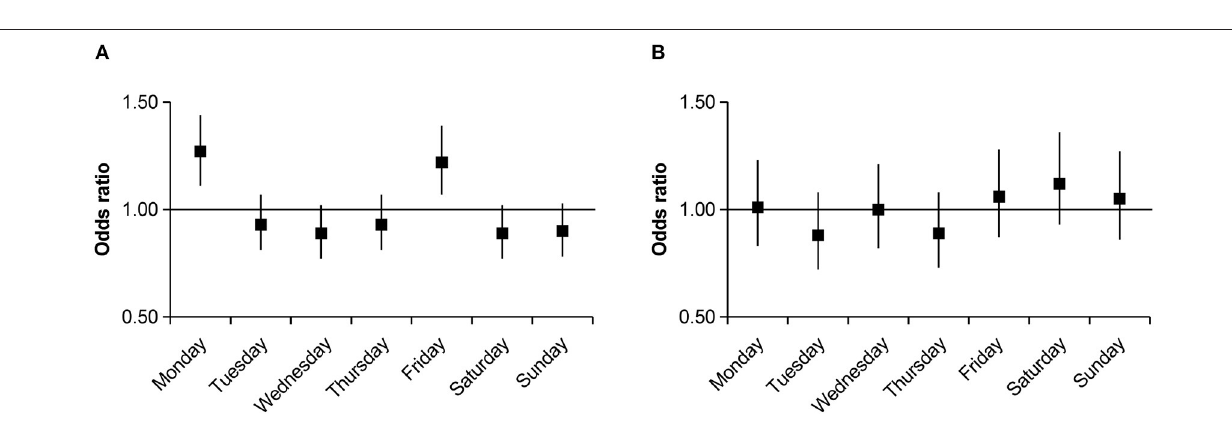
FIGURE 4 | Odds ratios with 95% confidence intervals for weekly variations of intracerebral hemorrhage occurrence stratified by residence group compared with the average numbers. (A) Urban group. (B) Rural